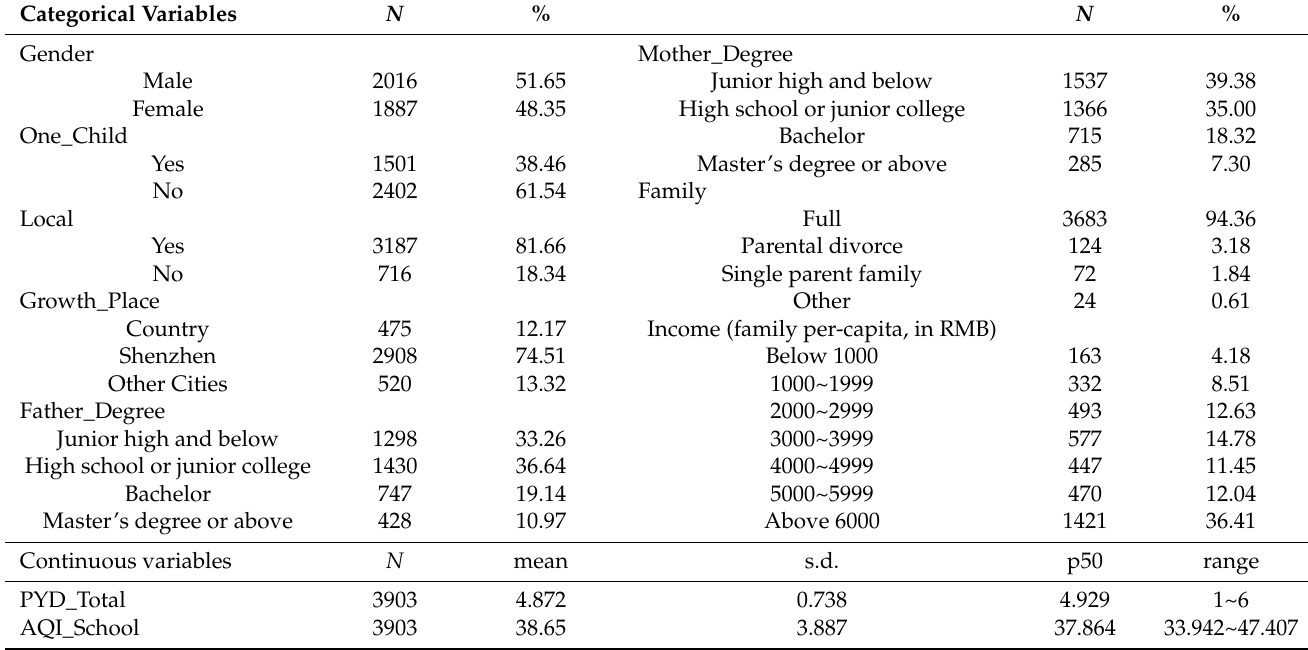
Table 3. Descriptive statistical